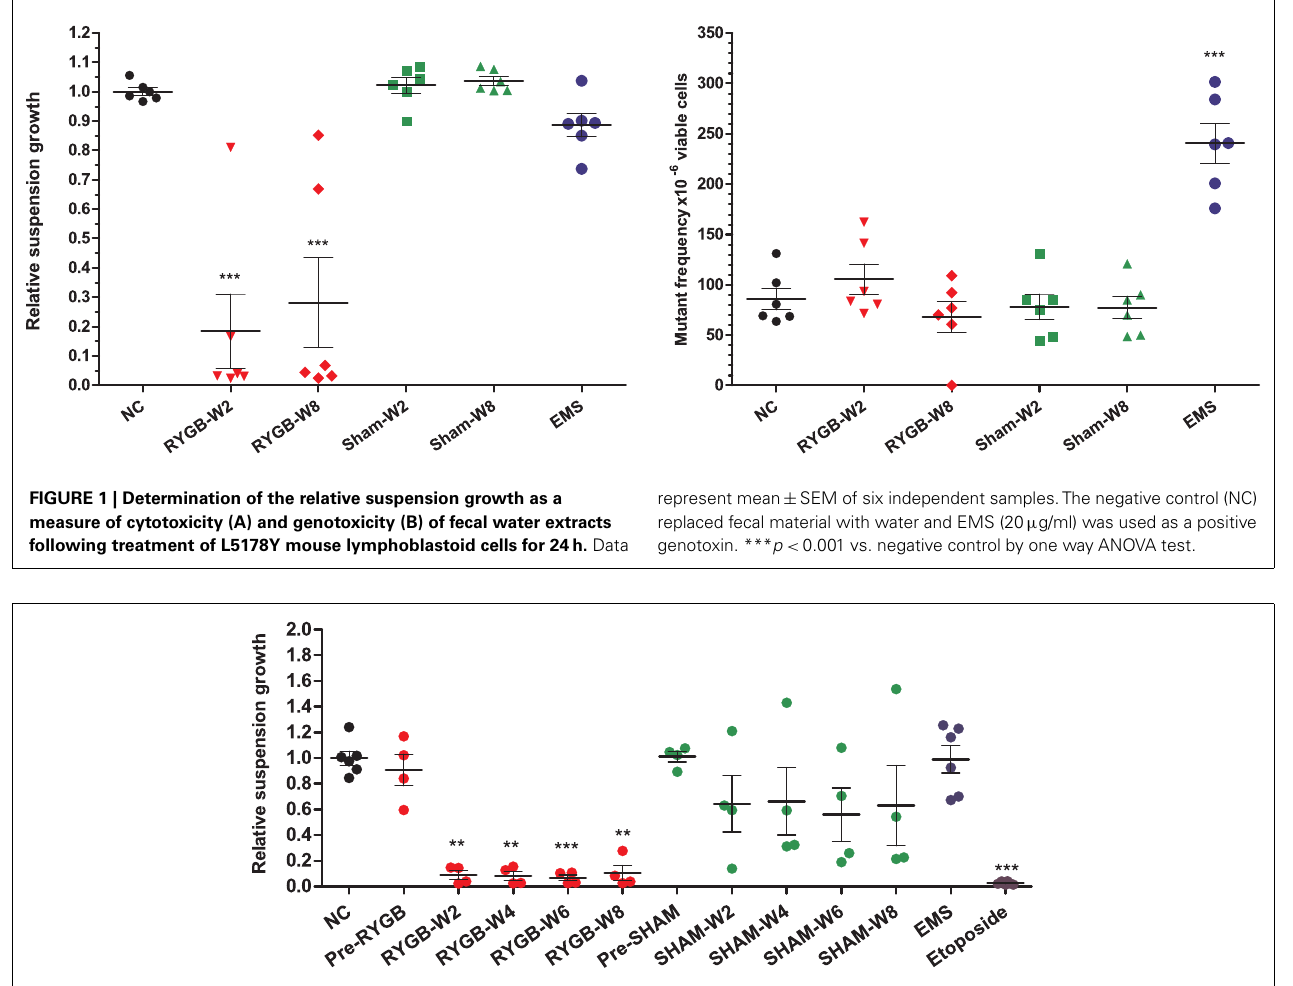
FIGURE 2 | Determination of the relative suspension growth (RSG) of L5178Y mouse lymphoblastoid cells after 24h exposure to individual fecal water extracts from four sham and four RYGB-operated rats at pre-surgery, 2, 4, 6, and 8weeks post surgery. The negative control (NC)